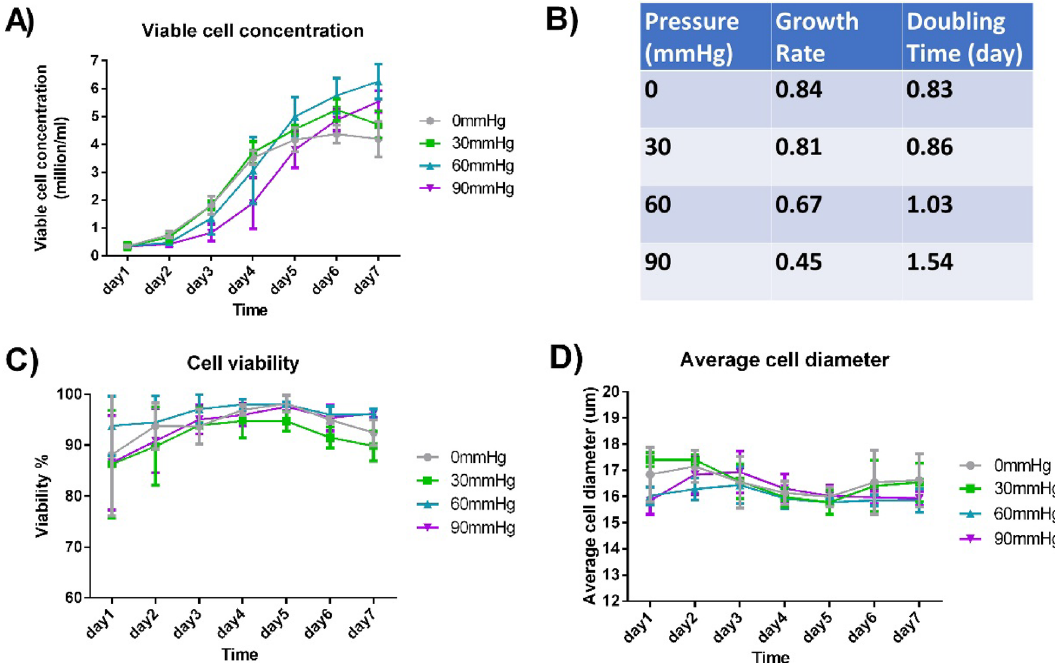
Figure 2. Cell growth under different pressure conditions. ( A ) Viable cell concentration in the culture system for up to 7 days. ( B ) CHO cells’ growth rate and doubling time under different pressure conditions on Day 3. ( C ) Cell viability across the 7-day culture. ( D ) Change of average live-cell diameter across the 7-day culture. ( n = examined. Compared with 0 mmHg group, initial cell proliferation was significantly slowed down in 60 mmHg and 90 mmHg groups (Fig. 2A). On Day 3, the cell growth rate under 60 and 90 mmHg pressure was lower